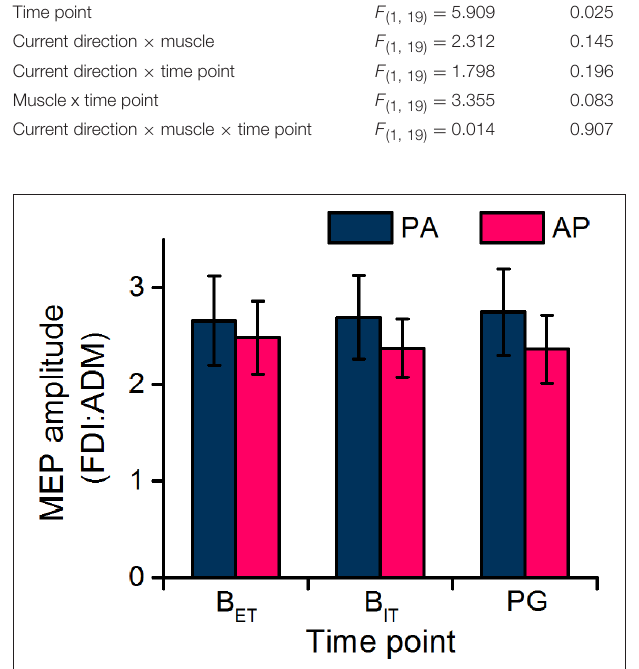
FIGURE 4 | Ratio of FDI and ADM MEP amplitudes recorded during the extra-task baseline (B ET ) and the action observation task (intra-task baseline, B IT ; precision grip,